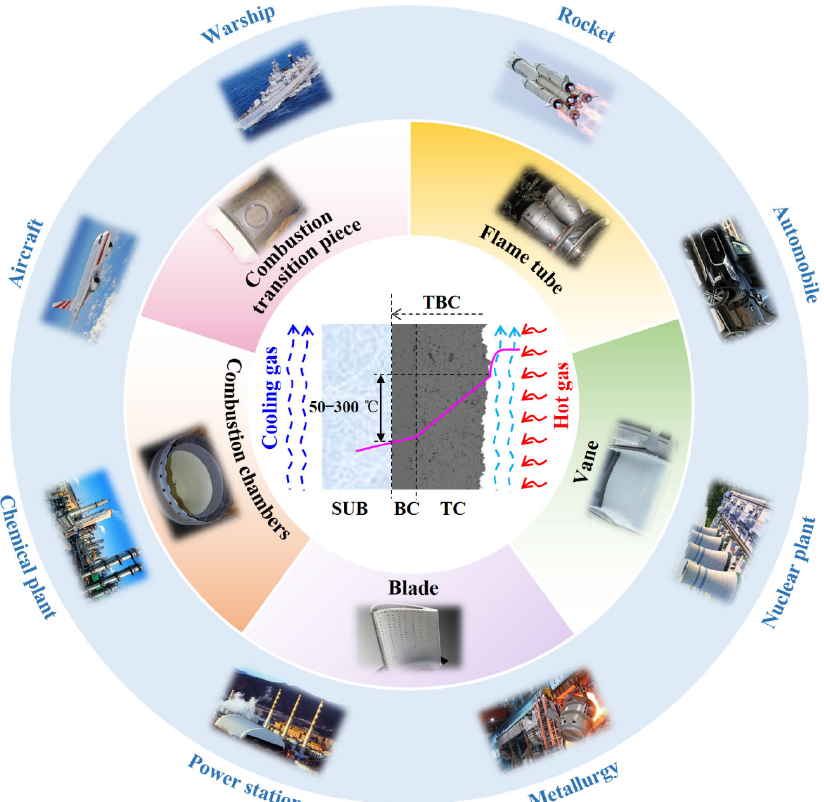
Fig. 1 Typical double-layer TBC system composed of the ceramic top coat and bond coat, and its application to alloy structural components in industrial